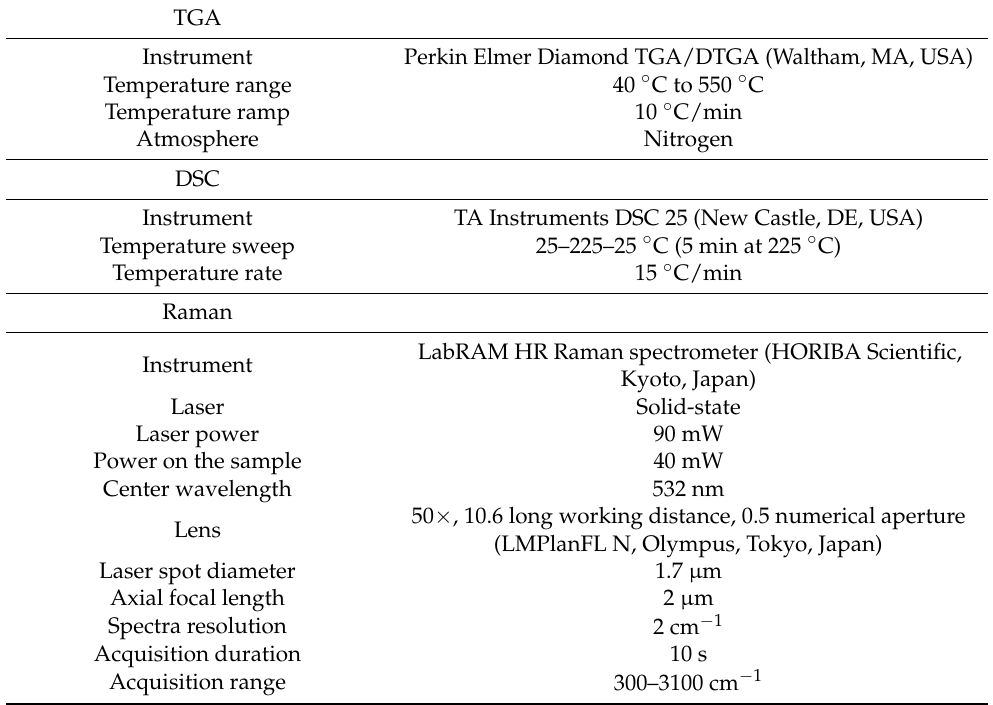
Table 1. Parameters for the thermal and spectroscopic